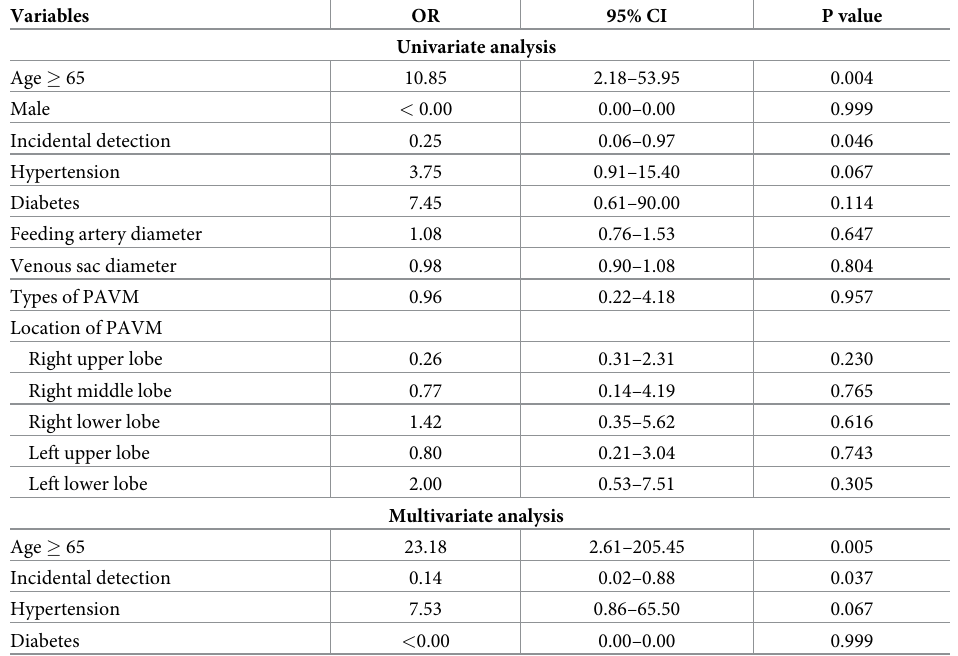
Table 2. Risk factors associated with cerebral complications in patients with pulmonary arteriovenous malforma- tions (n =